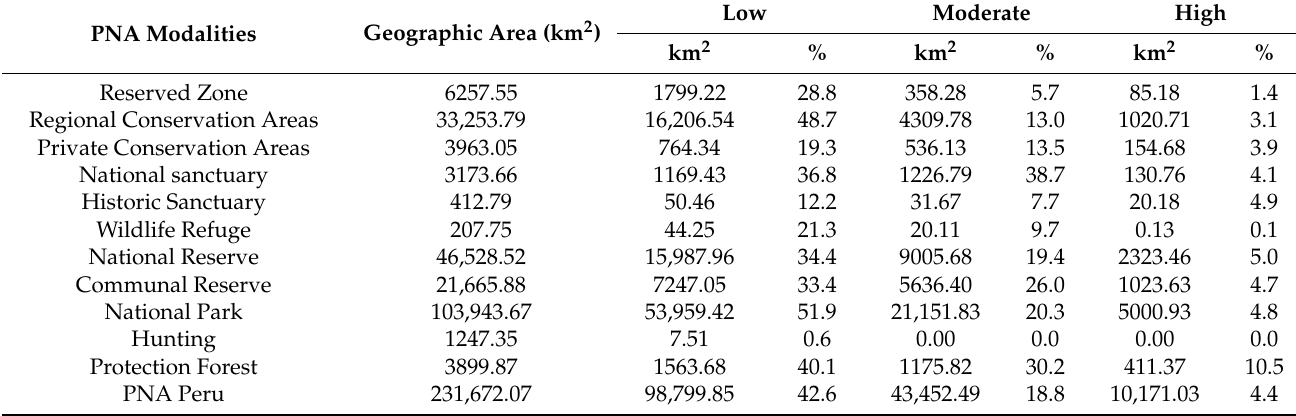
Table 5. Total potential distribution area predicted that is protected by the modalities of Protected Natural Area in Peru. PNA